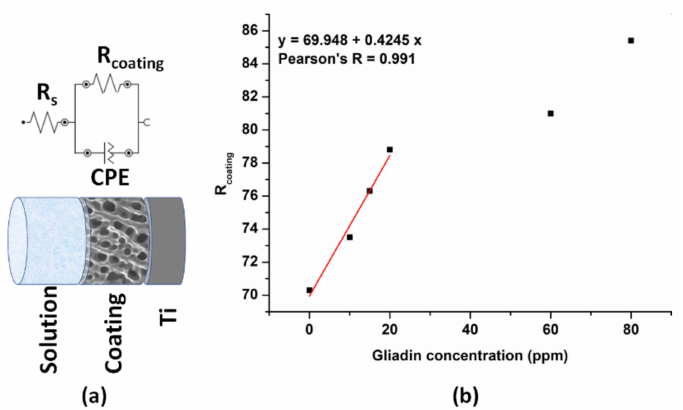
Figure 7. The equivalent circuit used to fit the impedance data and physical attribution to each value ( a ); R coating vs. gliadin concentration ( b ).